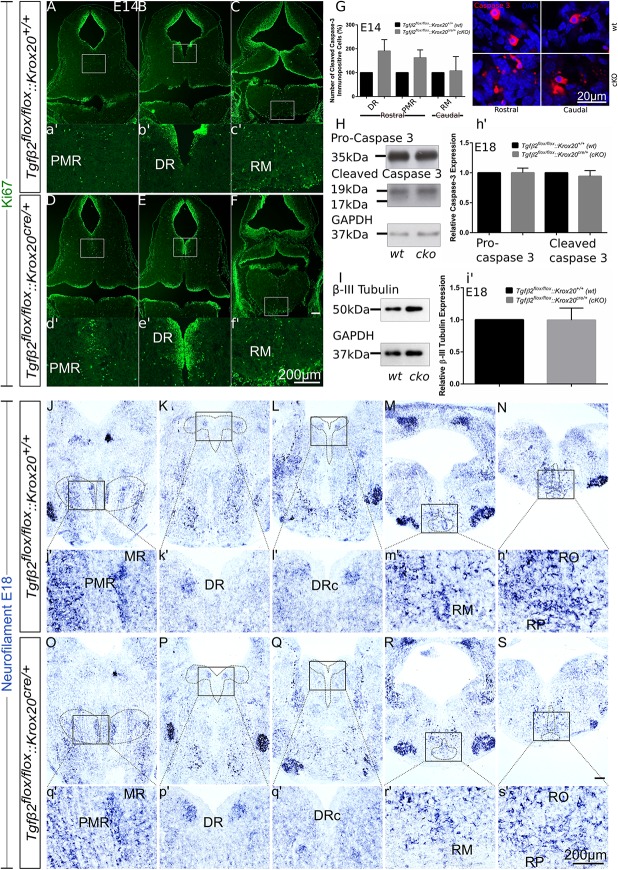
Cell death analysis in hindbrain of Tgfβ2flox/flox:Krox20cre/+ during embryonic development. (A–F) Immunofluorescence for the proliferation marker Ki67 in hindbrain coronal fixed cryosections from WT and Tgfβ2flox/flox:Krox20cre/+ at embryonic day (E) 14 shows increased immunoreactivity in the PMR, DR, or RM. (a′–f′) Represent higher magnification of the respective white-boxed areas in (A–F). (G) Counting of cleaved caspase 3 immunopositive cells in wt and cKO at E14 in the areas DR, PMR, and RM. Not significant, using the unpaired two-tailed Student’s t-test n = 4. Data are given as mean ± SEM, the mean of wt littermate was set to 100. (H,I) Immunoblot analysis of homogenates from hindbrain of wild type (wt) and Tgfβ2flox/flox:Krox20cre/+ (cKO) shows protein expression of pro-caspase 3, cleaved caspase 3 and β-III tubulin. (h′,i′) Quantification after densitometric analysis of the signal ratio protein of interest: GAPDH, not significant, using the two-tailed unpaired Student’s t-test, n = 4. 30 μg protein was loaded per lane. (J–S) ISH for Neurofilament in hindbrain of E18 mice. (j′–s′) Represent higher magnification of the respective black-boxed areas in (J–S). DR, dorsal raphe; PMR, paramedian raphe; RM, raphe magnus; RO, raphe obscurus; RPA, raphe pallidus. Scale bar: 200 μm, (G): 20 μm.